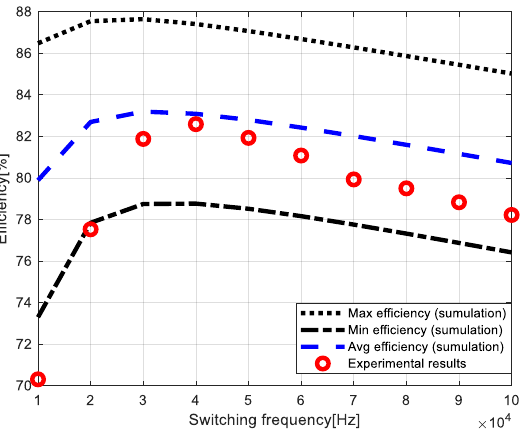
Figure 7. Relation between input voltage and input power in push – pull converter (PM wind tur- bine).